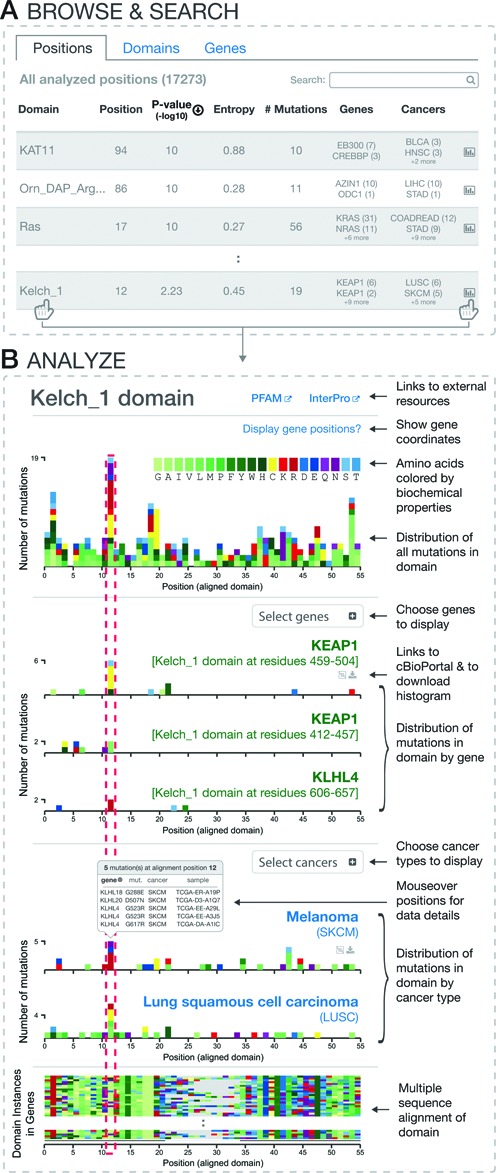
Interactive exploration of mutation hotspots in protein domains. (A) Searchable and sortable tables of all domain mutation hotspots by positions, domains and genes. (B) Domain details page with multiple sequence alignment and interactive mutation histograms.